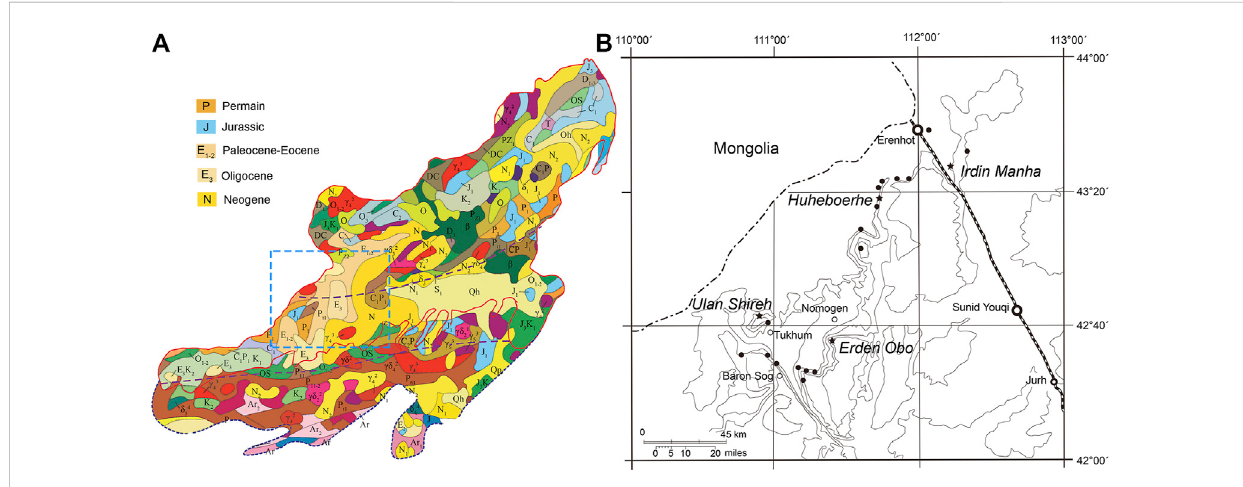
GeologicalmapandfossillocalitiesoftheErlianBasin. (A) geologicalmapoftheErlianBasin(modi fi edfromZhangetal.,2019,Fig.3,withpermission fromS.Fu); (B) PaleogenefossillocalitiesintheErlianBasinwithsolidstarsindicatingthelocalitieswherenewartiodactylfossilswereunearthed(modi fi ed from Bai et al., 2018, Fig.